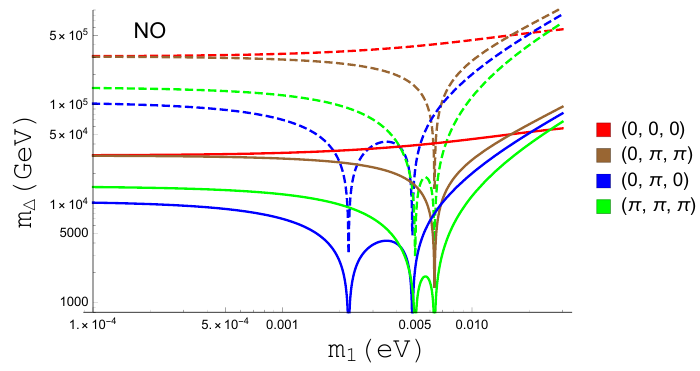
Figure 2 . Comparison of the maximum expected m ∆ probed by the upcoming µ → 3 e experiment, Mu3e [101] (Dashed), and the current constraints from the SINDRUM experiment [100] (Solid) for different sets of neutrino CP phases ( δ CP , α 21 , α 31 ) and varying lightest neutrino mass, in the NO scenario. All other parameters are given by the best fit parameters in table